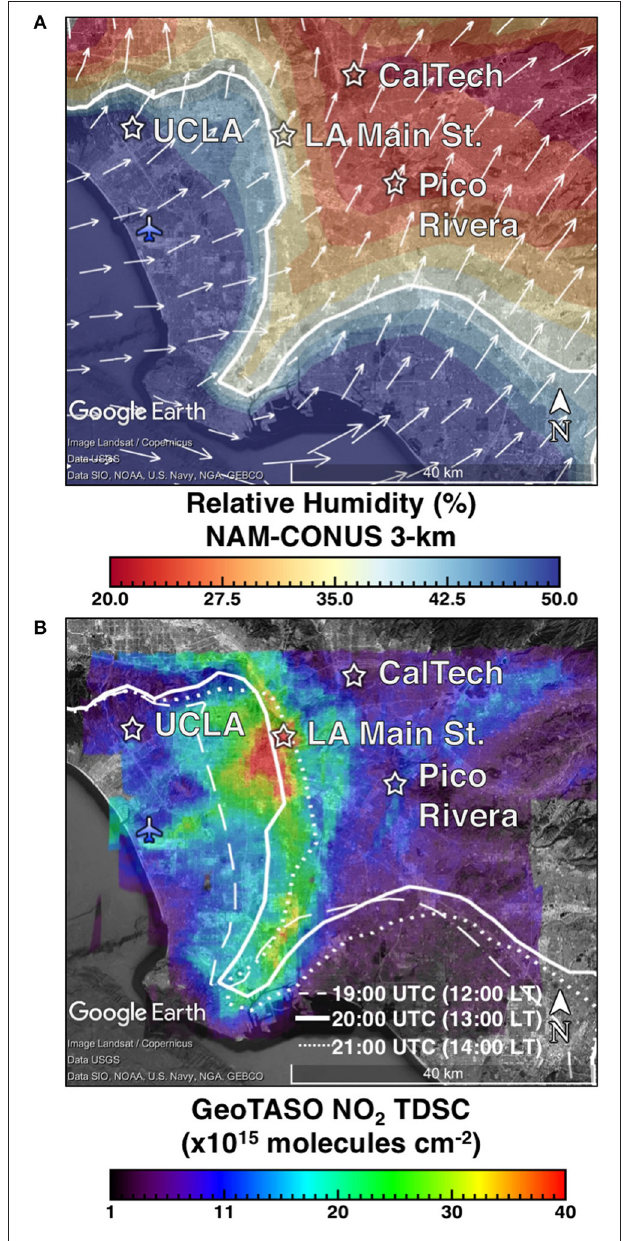
FIGURE 9 | (A) Relative humidity from the NAM-CONUS 3-km nest at 20:00 UTC (13:00 LT) with overlaid modeled boundary layer averaged wind vectors and a white contour at 40% relative humidity boundary indicating the sea breeze front position and (B) NO 2 TDSCs over the western side of the LA Basin during Raster 2 with the indicated sea breeze front position identified from the NAM-CONUS 3-km nest 40% relative humidity contour at 19:00UTC (long dashes: 12:00 LT), 20:00UTC (solid: 13:00 LT), and 21:00UTC (dotted: 14:00